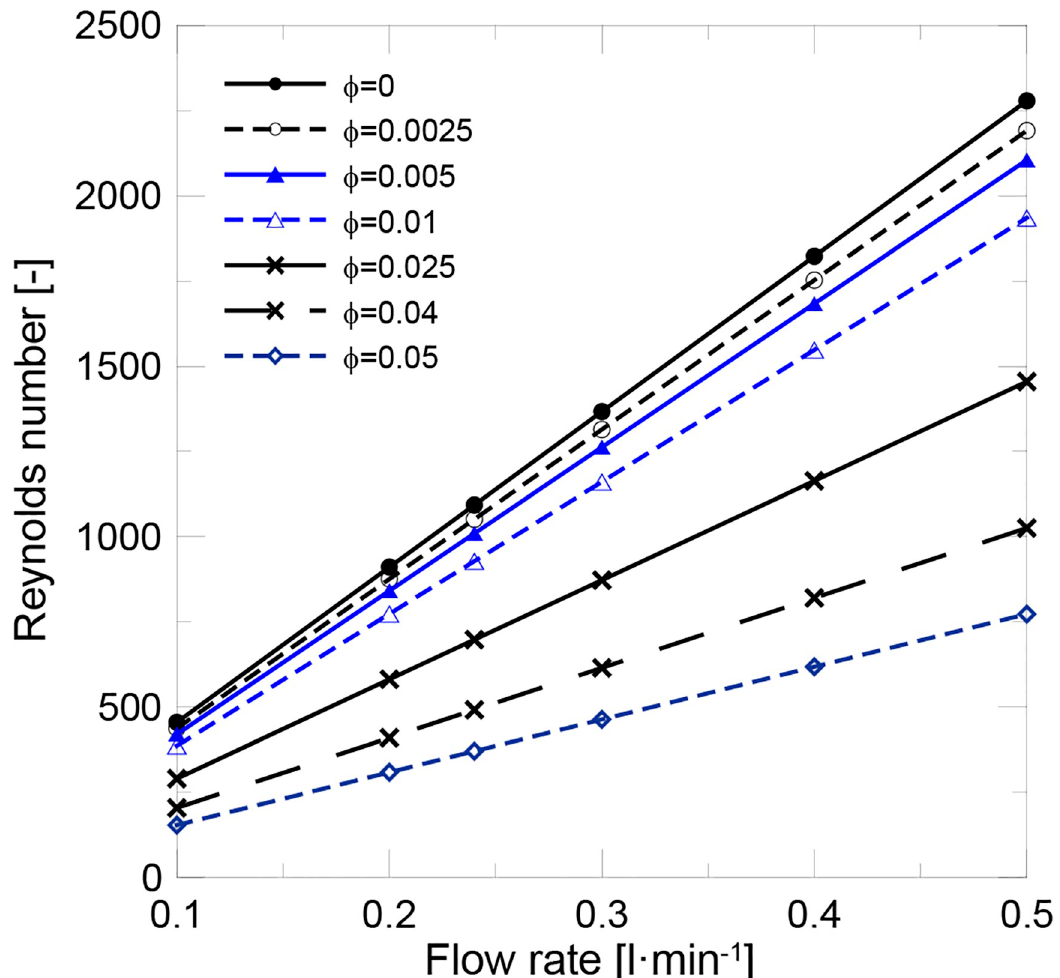
Fig 4. Evolution of the Reynolds number with flow rate and volume